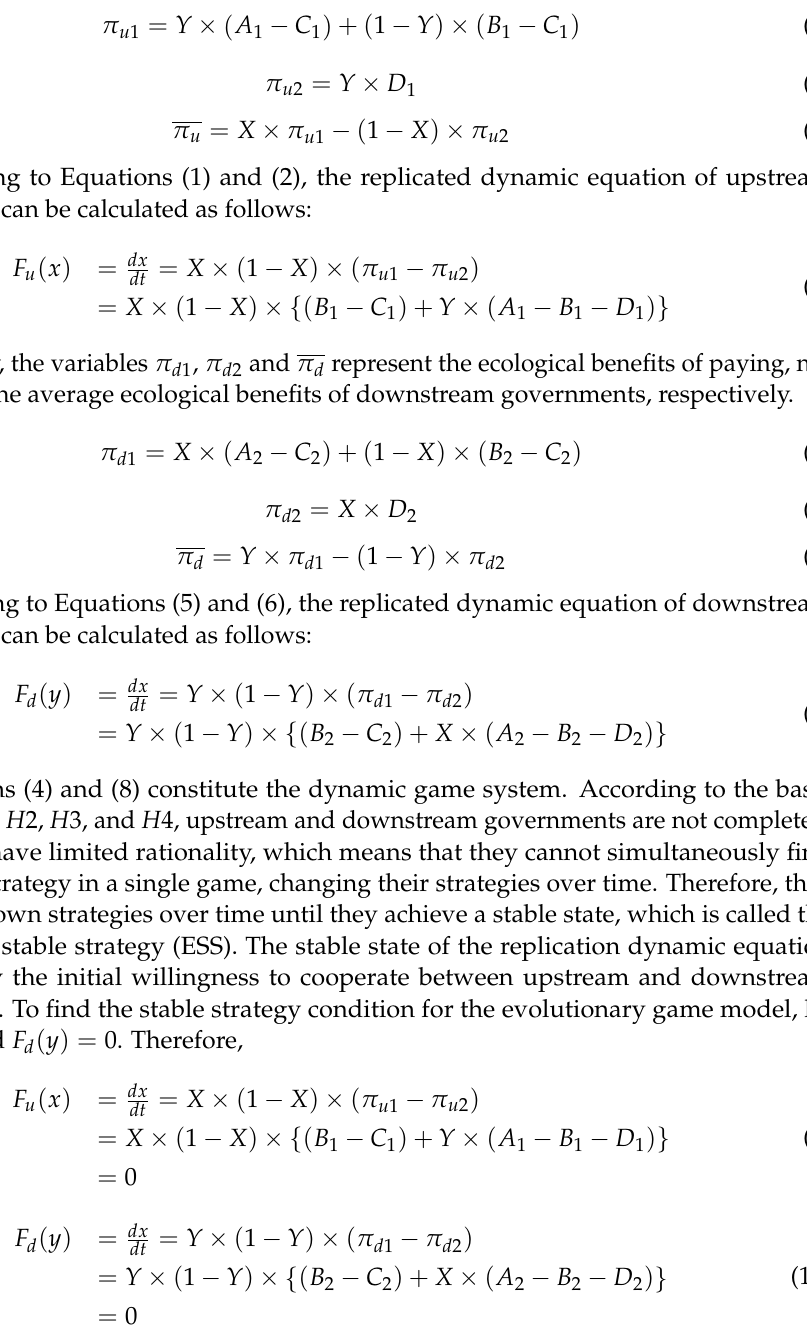
Table 2. Payoff matrix for both players with non-supervision of the central government. When the Central Government Does Not Supervise Local Governments Upstream governments River basin and strategies Protecting (X) Not protecting (1–X) Downstream Compensating (Y) ( A 1 − C 1 , A 2 − C 2 ) ( D 1 , B 2 − C 2 ) governments Not compensating (1–Y) ( B 1 − C 1 , D 2 ) ( 0,0 ) The variables π u 1 and π u 2 represent the ecological benefits when upstream gov- ernments choose the protecting and not protecting strategies, respectively. Variable π